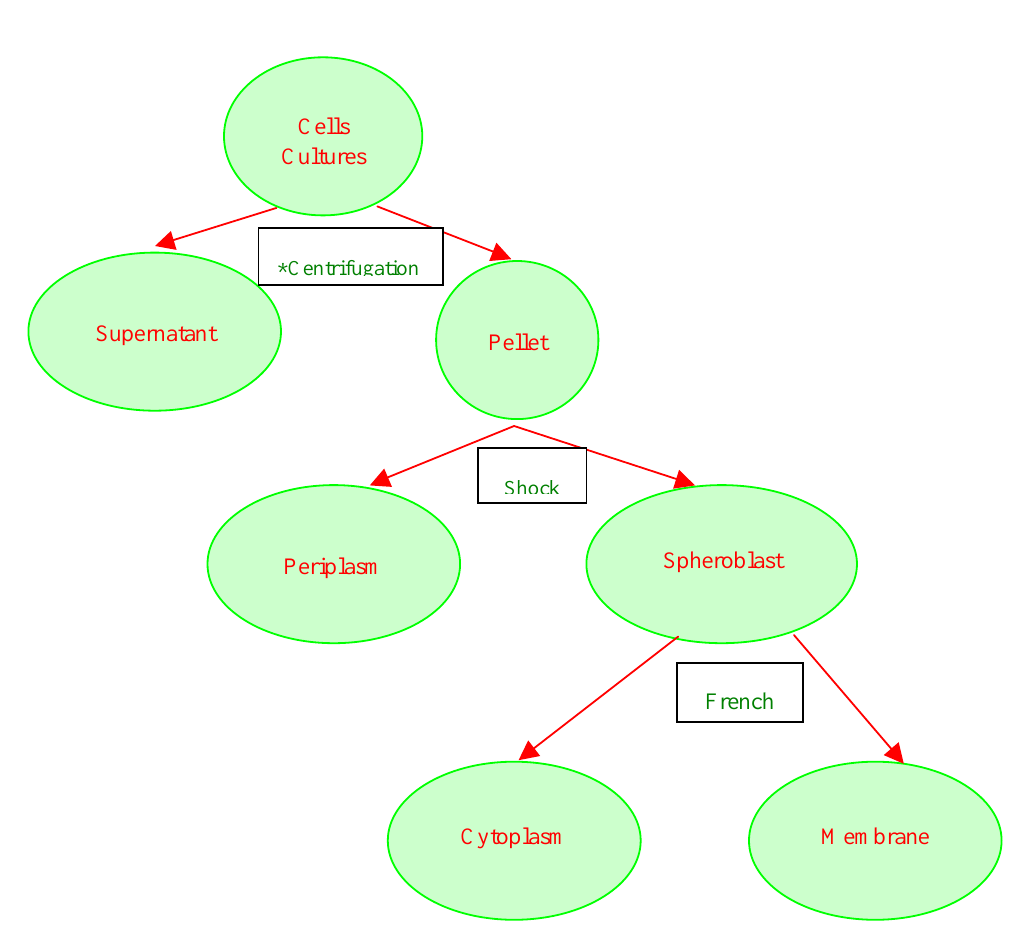
Figure 1. Procedure utilized for physical and chemical separation of various cell fractions of C ytophaga